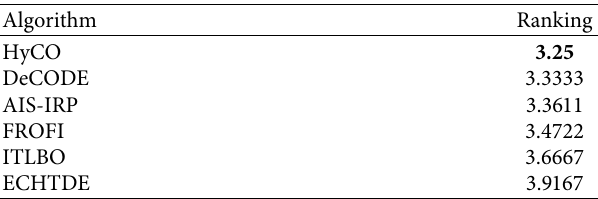
Table 3: Rankings obtained by the Friedman’s test for HyCO and other compared algorithms on 18 COPs with 10d from CEC 2010.